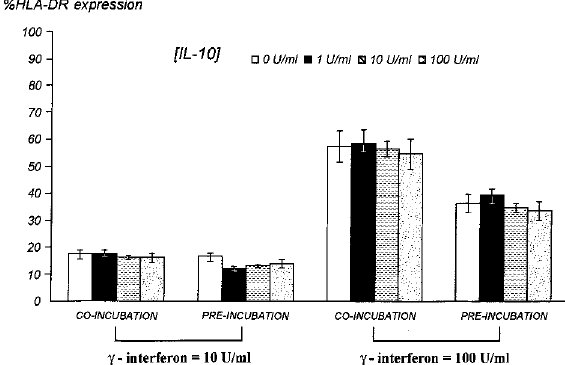
FIG. 1. The effect of interleukin-10 on g -interferon induced HLA-DR expression. (The error bars represent ±1 standard deviation.) For all ANOVA, P -value >0.05.